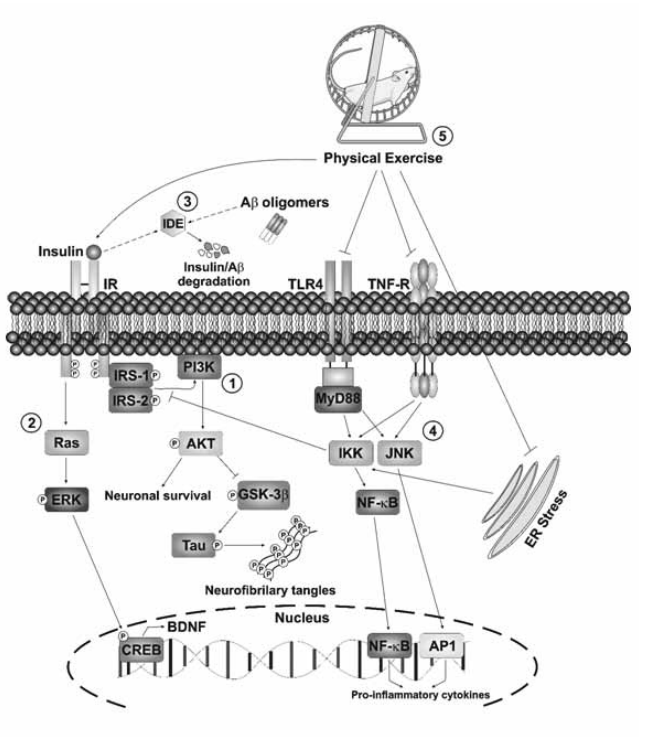
Figure 1. In hippocampal neurons, binding of insulin to the IR active routes of PI3-K/Akt and MAPKs. 1) PI3K/Akt activation leads to inhibition of GSK3 beta activity, reducing phosphorylation of tau protein, a protein strictly involved in AD. This pathway also promotes neuronal survival by an antiapop- totic effect through FOXO phosphorylation and